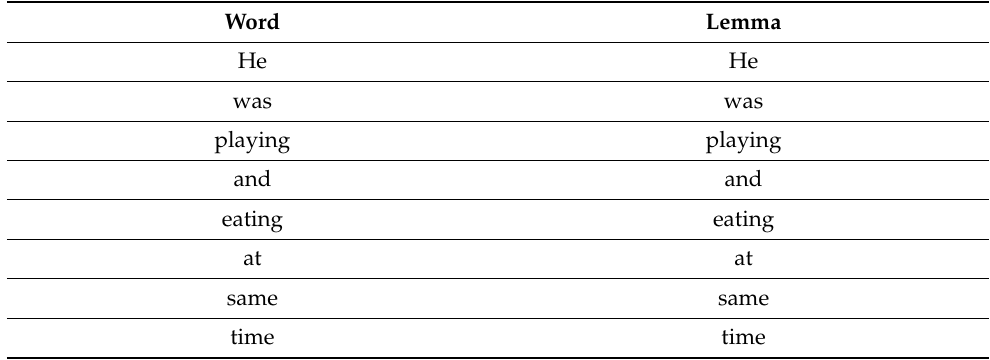
Table 5. Word-to-root-word conversion using lemmatization.